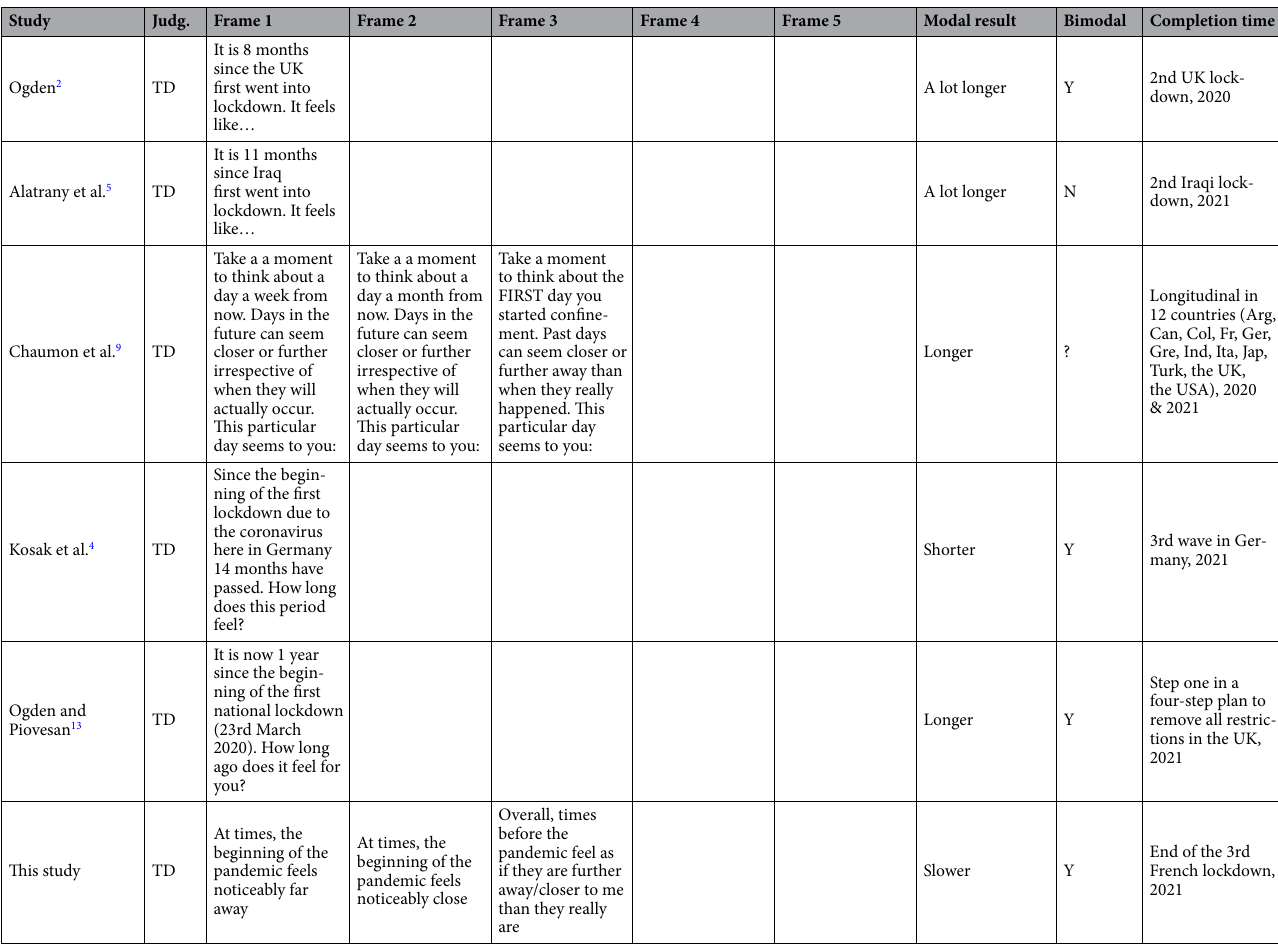
Table 1. A summary of existing passage of time and temporal distance judgements studies related to the Covid-19 crisis. When possible, similar frames (i.e. the scale given to respondents when probing their judgements) are grouped on the same